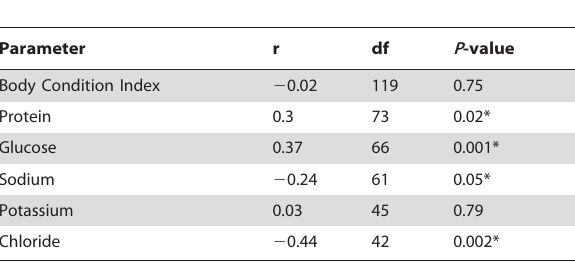
Table 2. Pearson correlation between Bd -load (genomic equivalents determined by qPCR analysis) and parameters that loaded highly on the Fluid and electrolyte balance